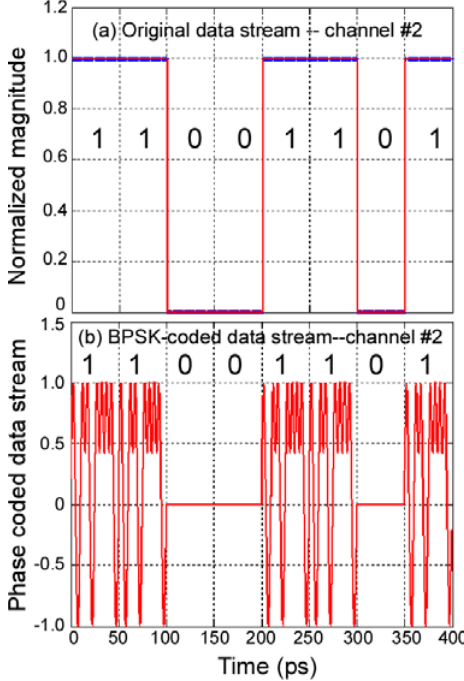
Figure 5. ( a ) original data stream 1 1 0 0 1 1 0 1 of channel #2; ( b ) phase-coded (BPSK) data stream of channel #2 using its phase code [0 π 0 0 π 0 0 0 0 π